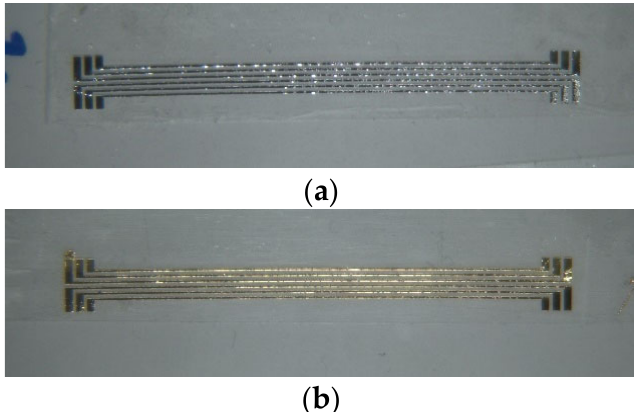
Figure 10. Test structures transferred to scotch tape. ( a ) Al 300 nm; ( b ) Au 300 nm.